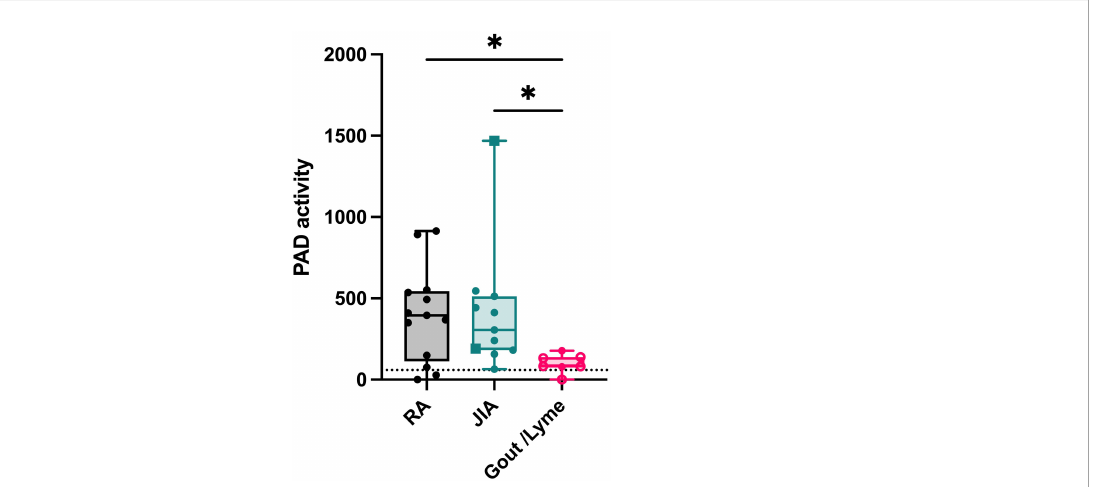
FIGURE 5 Extracellular citrullination in synovial fl uids of patients with RA and JIA. PAD activity was detected in synovial fl uids from patients diagnosed with rheumatoid arthritis (RA, n=12), Juvenile Idiopathic Arthritis (circles, oligoarticular JIA, n=8; rectangles, polyarticular JIA, n=2) or gout (open circles, n=4) and Lyme ’ s Disease (n=2). An Evans blue quencher concentration of 75 µM and a TAMRA-(GRGA) 4 substrate concentration of 0.5 µM were used. Error bars show min to max value, center values represent median value. Signi fi cance considered * for p<0.05 by Kruskal-Wallis. The detection limit in synovial fl uid was determined by inhibition of PAD activity through EDTA treatment (59 D RFU/min, dotted line).